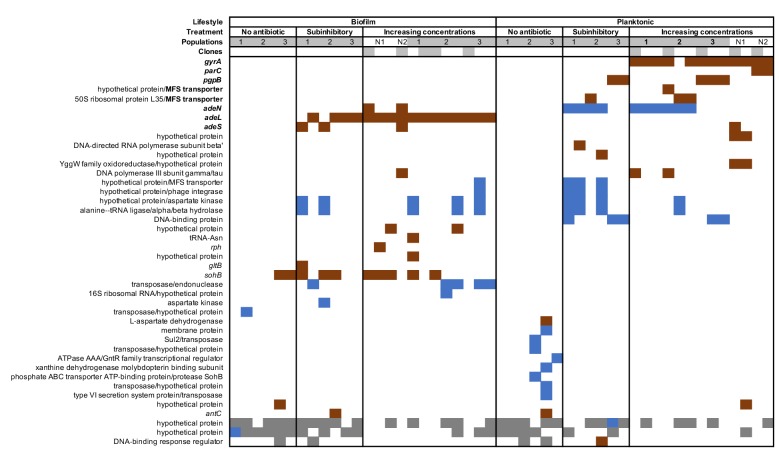
Mutated genes in the sequenced clones differ between treatments.Each column represents one clone. Gray shaded clones were used for MIC and fitness estimations. Red color indicates SNPs or small indels, blue color indicates new junction evidences and gray indicates missing coverage indicative of a deletion.